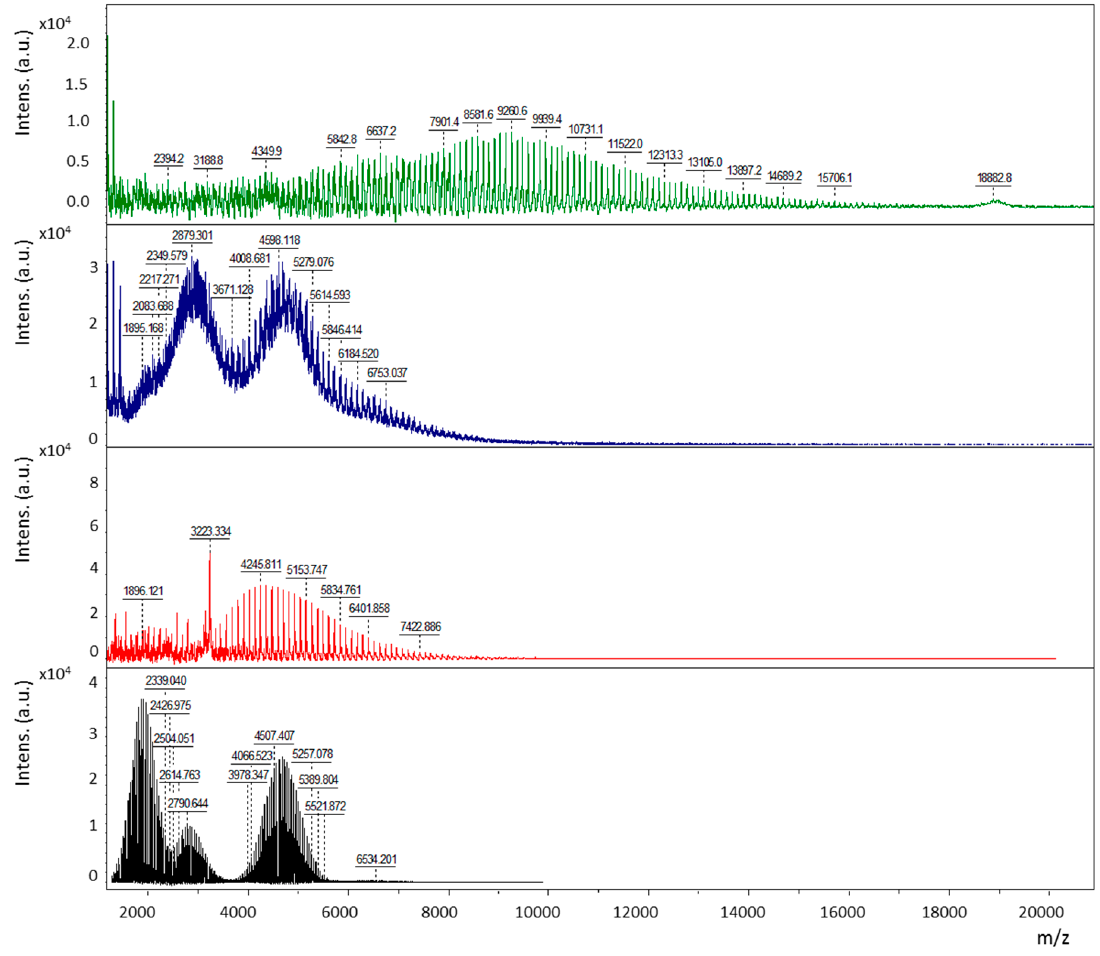
Figure 3. MALDI-ToF mass spectra of poly(ethylene glycol) (PEG)-peptide 3 (black), poly( N -isopropyl acrylamide) (PNIPAM)-peptide 4 (red), control without sortase (blue), and the product after the SrtA reaction (green).